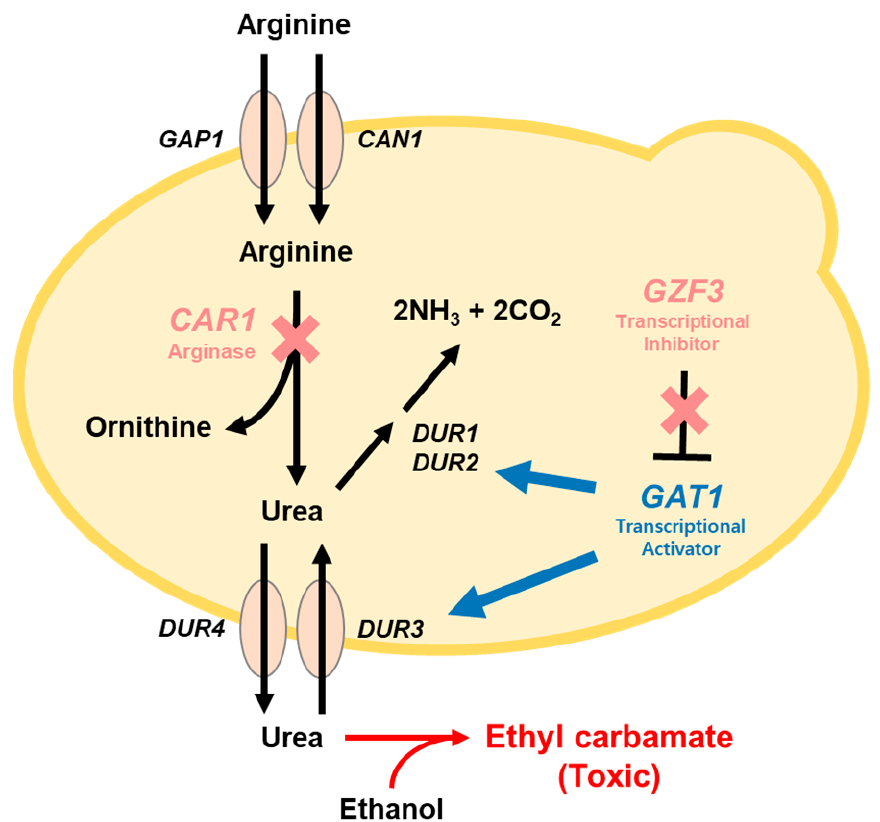
Figure 1. Metabolic pathway of ethyl carbamate formation from ethanol and urea in Saccharomyces cerevisiae. S. cerevisiae decomposes arginine into ornithine and urea by arginase enzyme encoded by CAR1 gene. The GZF3 gene is transcriptional activator related to the expression of urea absorption and degradation genes. GAP1 : General amino acid permease, CAN1 : Plasma membrane